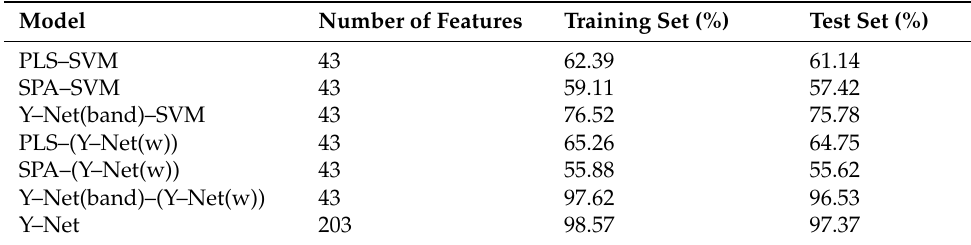
Table 1. Results of the classification of corn diseases. Model Number of